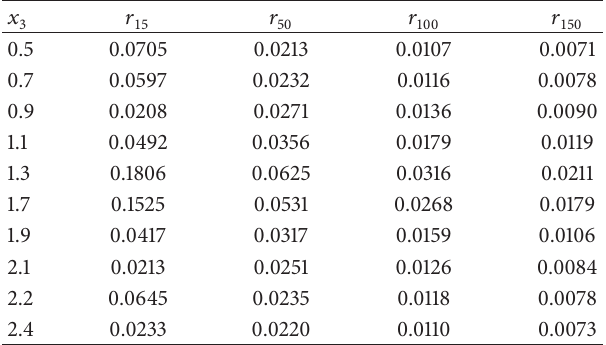
Table 1: The accuracy of the calculation of the magnetic field for 𝑥